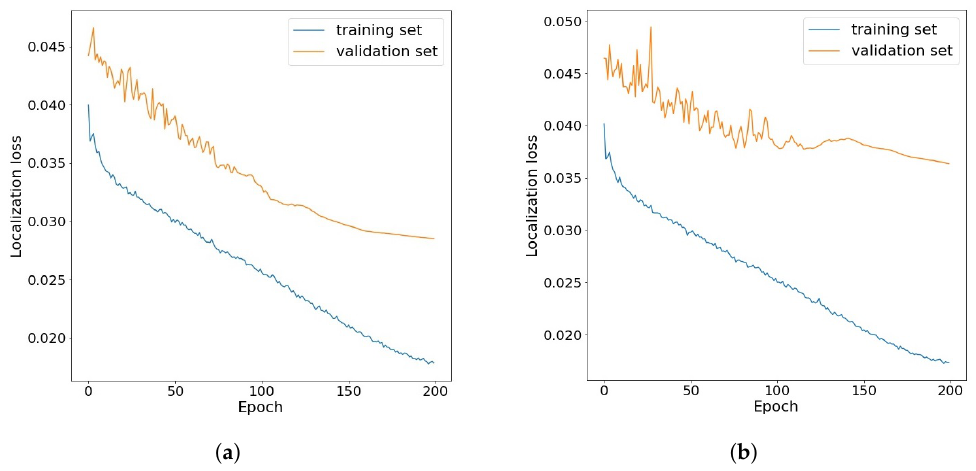
Figure 4. Example of localization loss change during transfer learning for Yolov3 model: ( a ) on the own original dataset ( b ) on the CLAHE dataset.